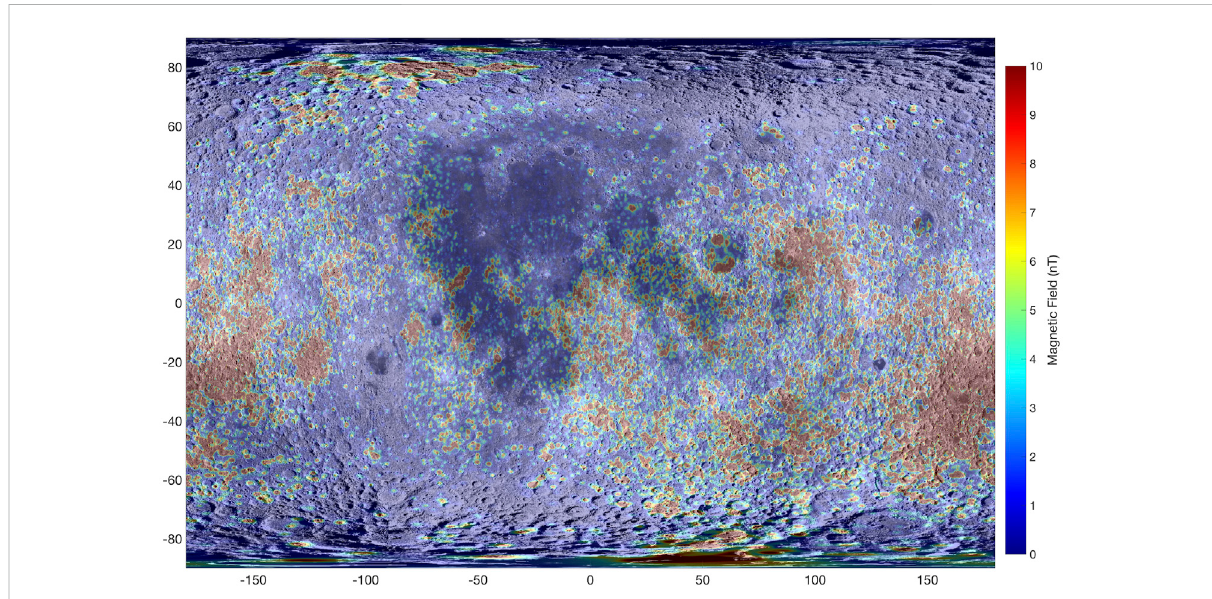
FIGURE 2 LunarProspector-derivedsurfacemodelmagnetic fi eldintensity(Ravatetal.,2020)overlaidonanLROCWAC100 m/pixelGlobalMorphologic basemap (I/F stretch: 0 – 0.07) inMercatorprojection.Magneticanomaliesare distributedbroadly across thesurfacewith little apparent topographic